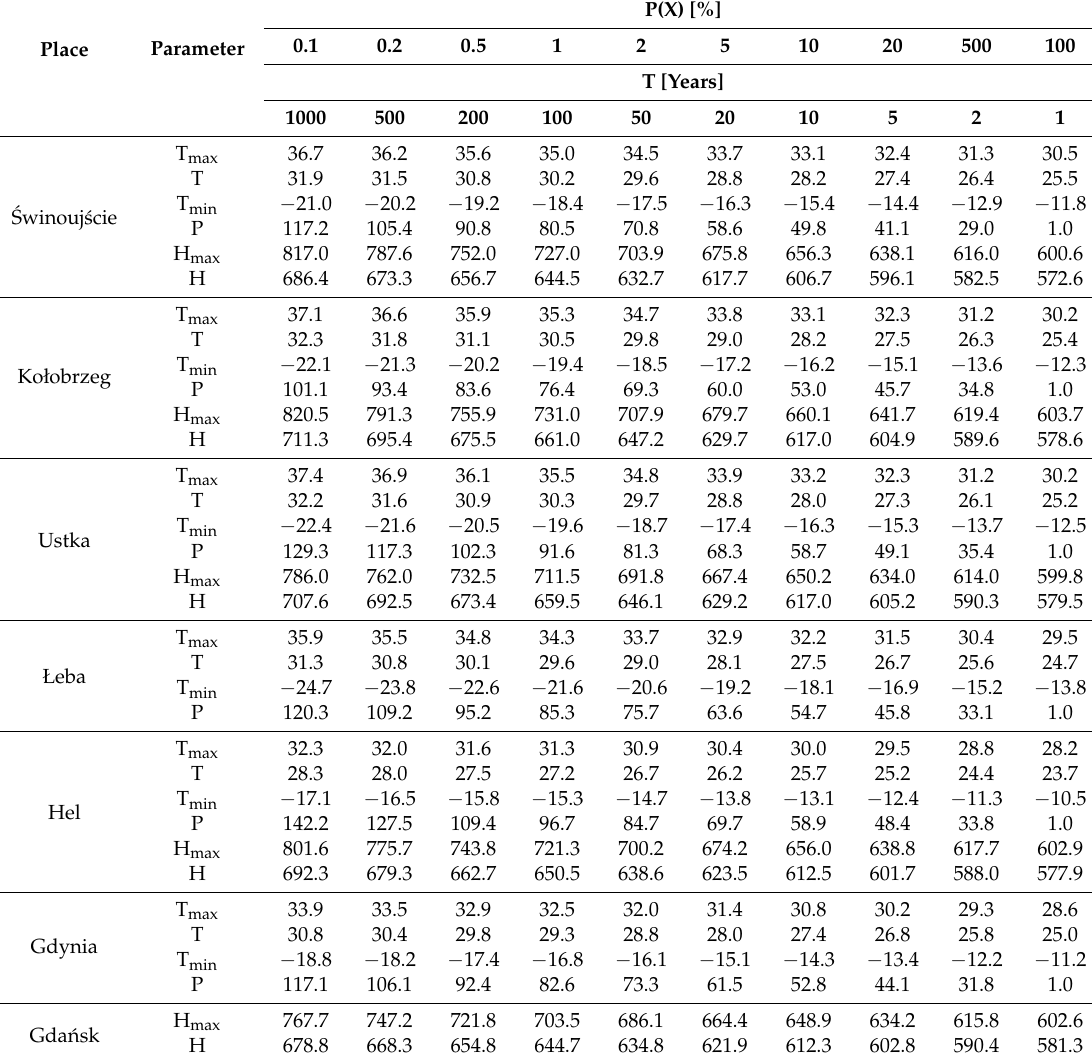
Table 3. Probability of extreme hydrometeorological events in the Polish coastal zone of the South Baltic (daily data from